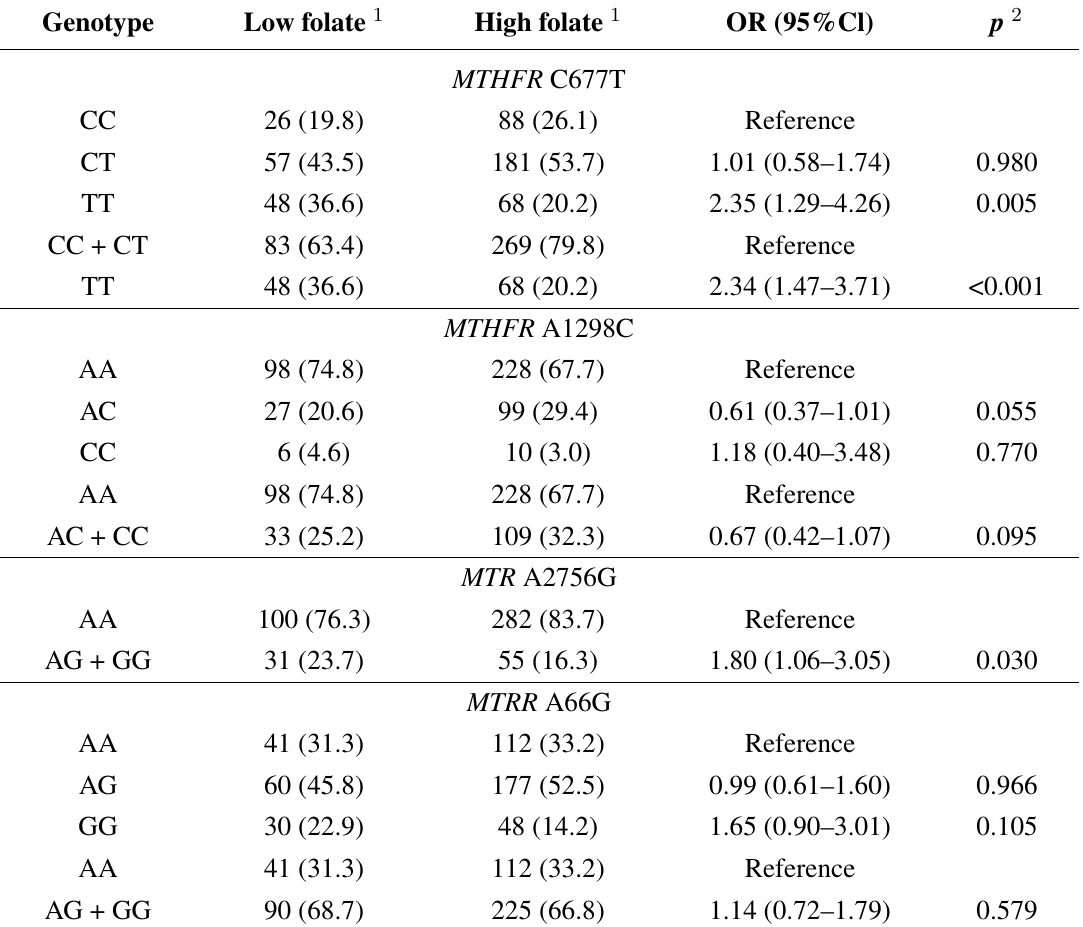
Table 4. Effects of gene polymorphisms on folate